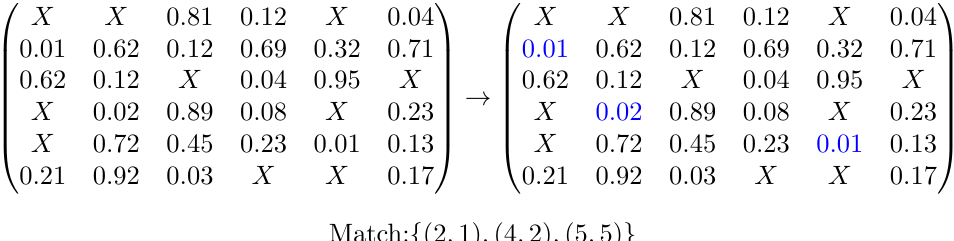
Figure 3. Example matrix used for the assignment of matching pairs. X indicates feature mismatches, marking a given pairing as